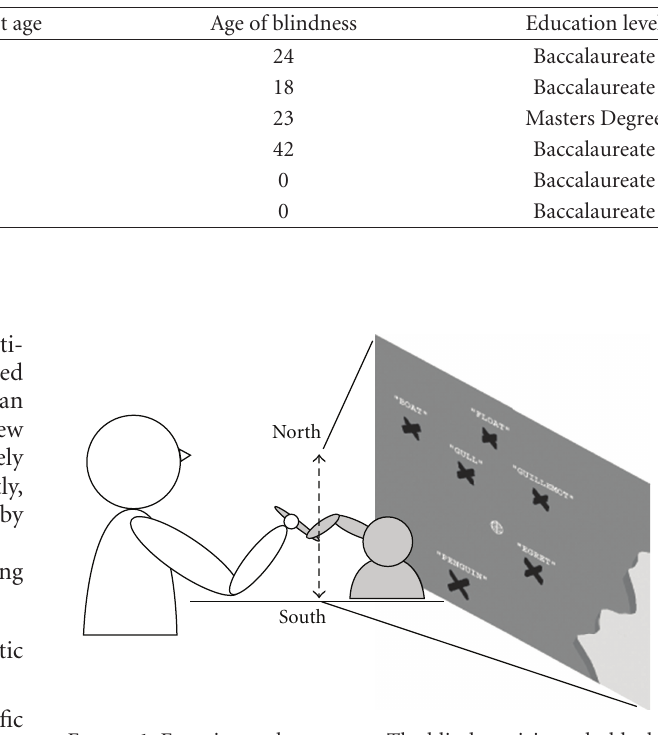
Figure 1: Experimental apparatus. The blind participant holds the force feed-back device and touches the virtual map of SeaTouch. The dark part of the map is the sea and the light one is the land. The crosses are the beacons and the white translucent sphere is the position of the haptic cursor. The virtual map is rendered in the vertical plane providing the implicit assumption that the workspace is aligned north